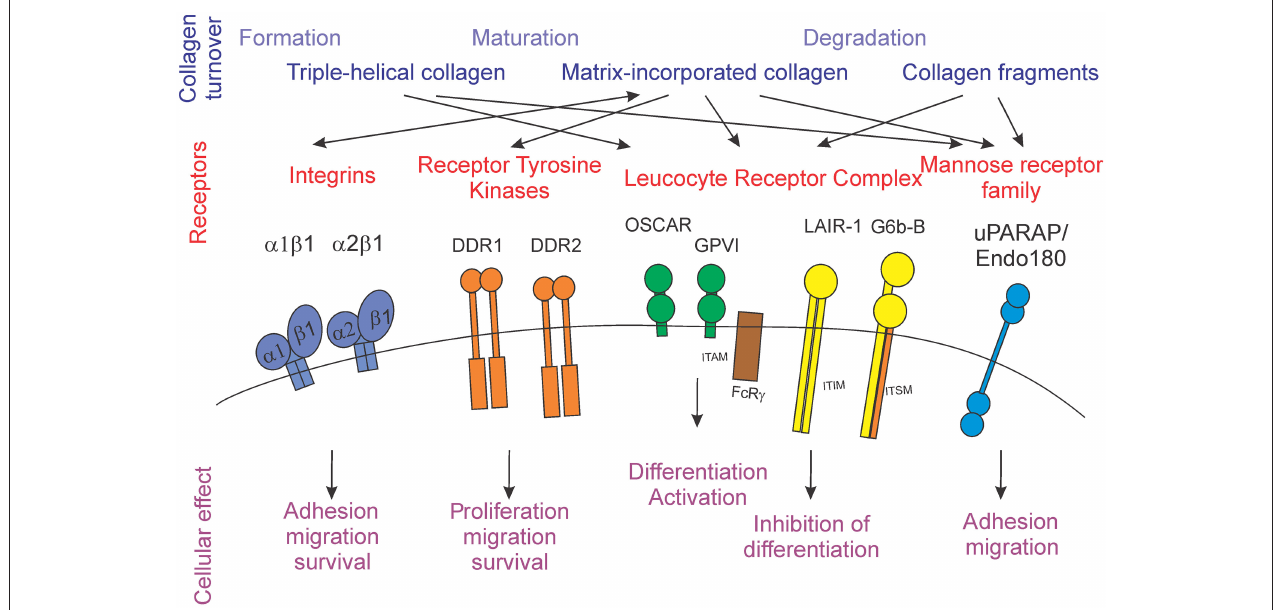
FIGURE 1 | Schematic representation of the stages of collagen turnover creating different forms of collagen (blue), different collagen receptors families (red) and individual receptors, and the cellular outcomes for collagen receptor-mediated signals